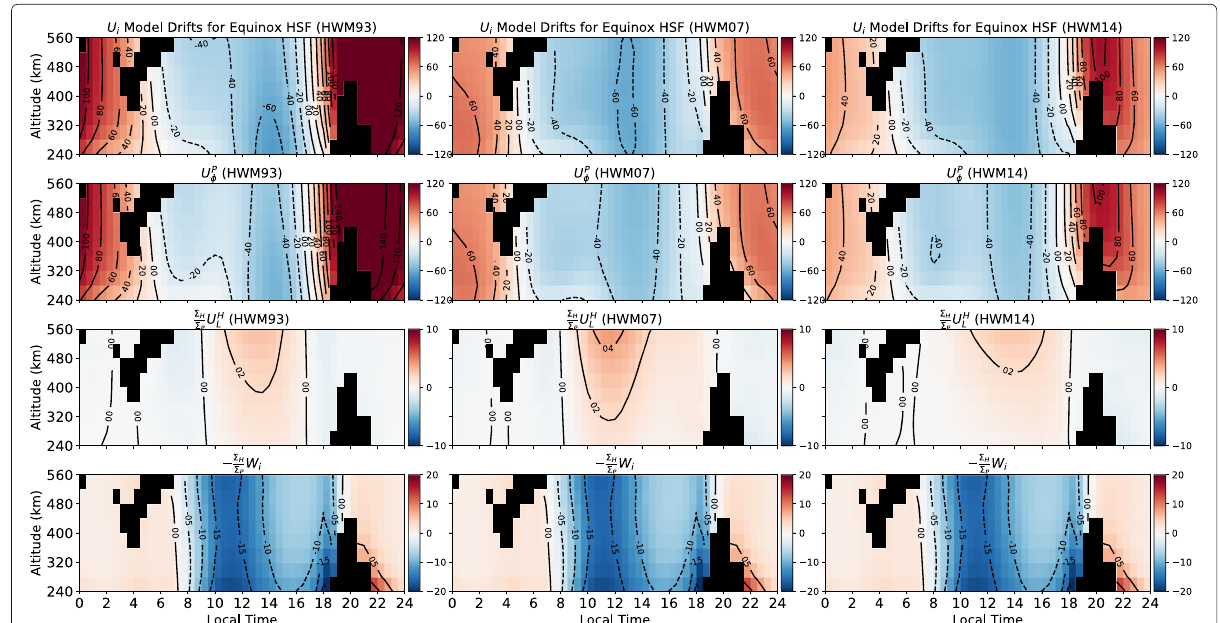
Fig. 9 The contribution of each term of Eq. 6 to the modeled zonal drifts. Equinox high solar flux (HSF)